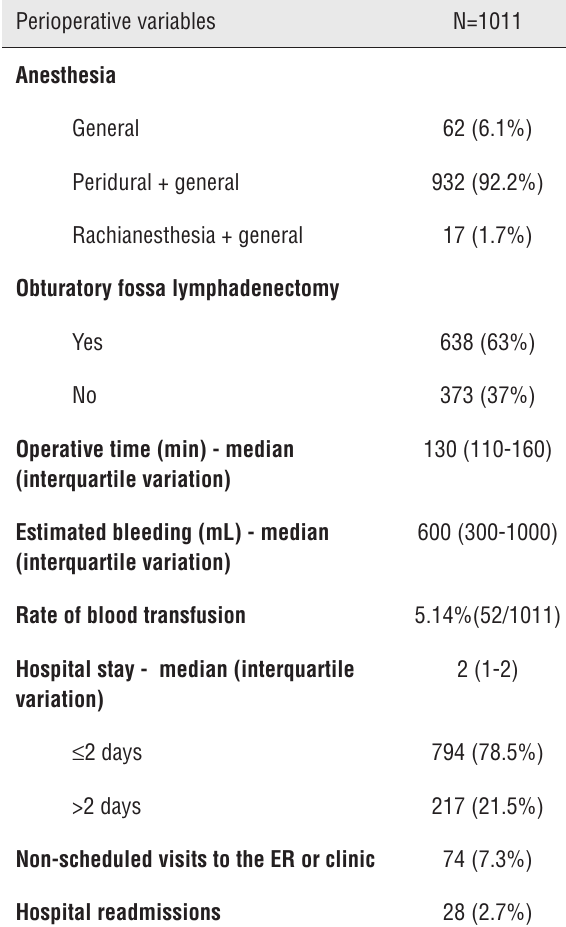
Table 3 - Peri-operative